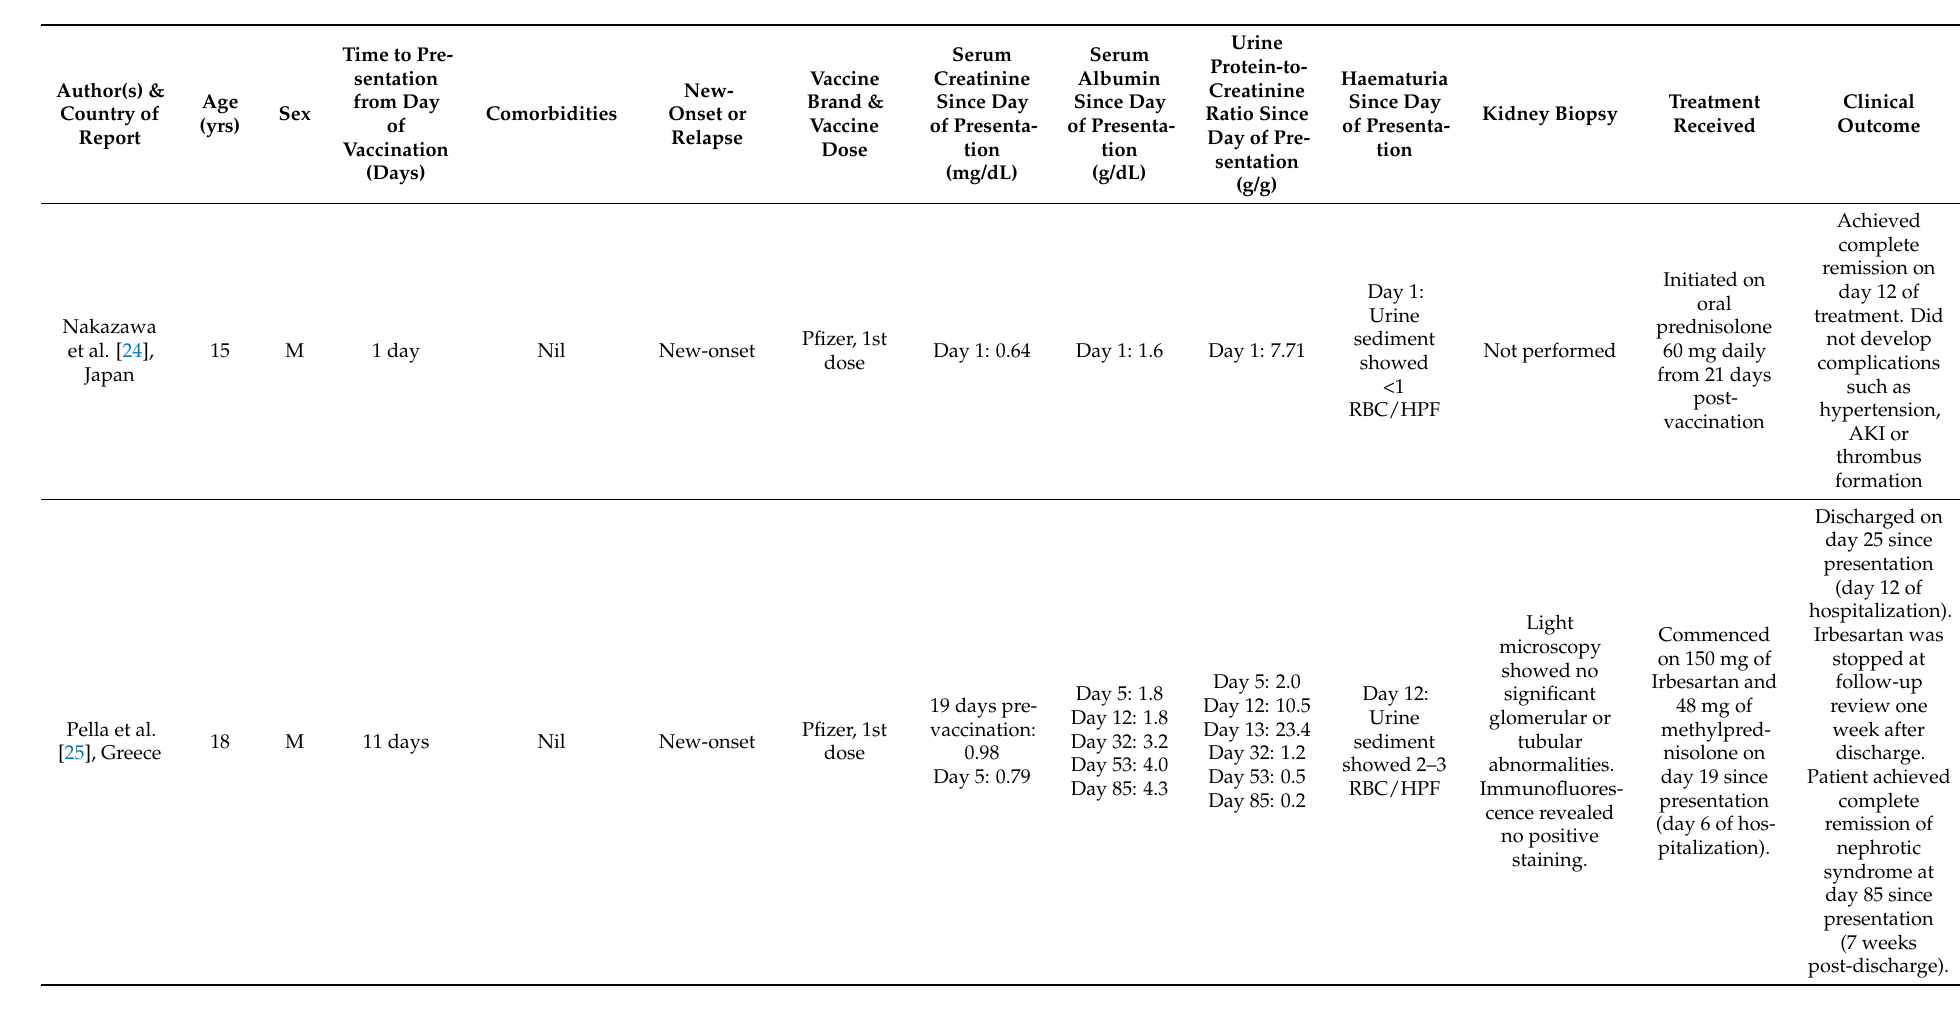
Table 2. Demographics and outcomes of children and adolescents with new-onset and relapsed nephrotic syndrome and tubulointerstitial nephritis following COVID-19